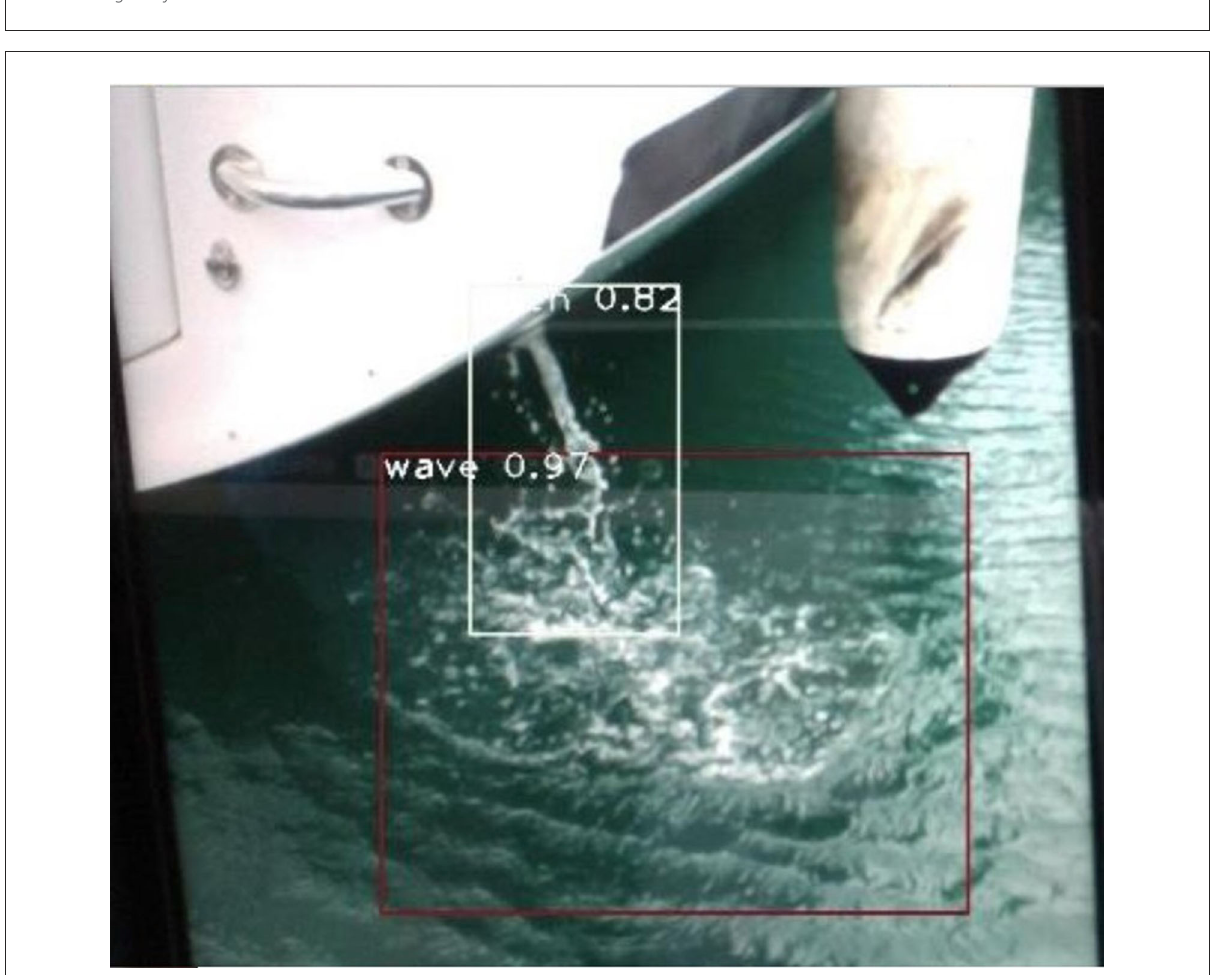
FIGURE4 The flow chart of the Raspberry Pi sending the results to the